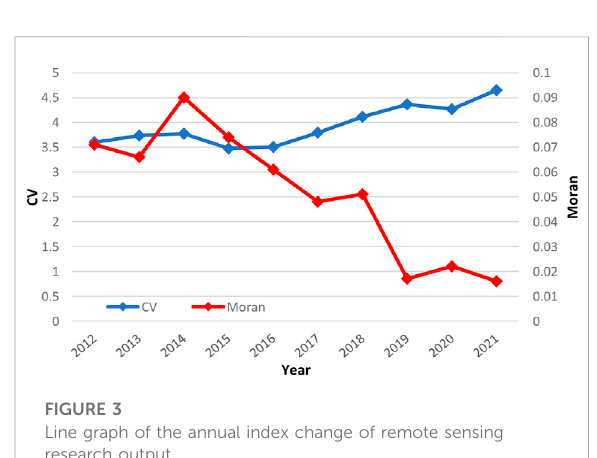
FIGURE 3 Line graph of the annual index change of remote sensing research output.